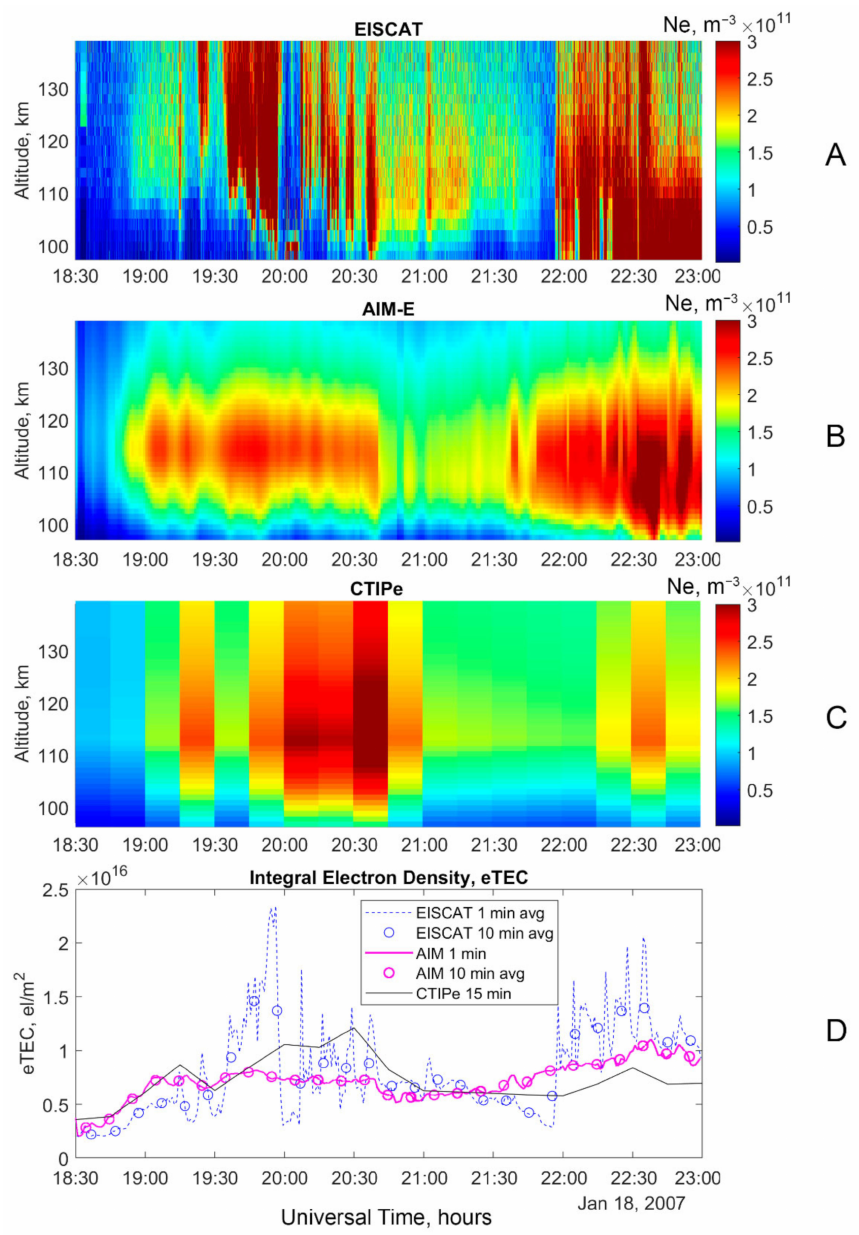
Figure 3. Variation of vertical distribution of electron concentration in the 96–140 km altitude range, for the 18 January 2007, 18:30–23:00 UT event, measured by the UHF EISCAT incoherent scatter radar ( A ) and calculated by AIM-E model ( B ) and CTIPe model ( C ). Panel ( D ) shows the integral value of the E layer electron content (eTEC) calculated in the vertical column in altitude range 96–140 km for the Tromso EISCAT incoherent scatter radar (blue line—1 min observation averages; blue circles—10 min observation averages); AIM-E model (pink line—minute values; pink circles—10 min averages), and for the CTIPe model, 15 min results (black